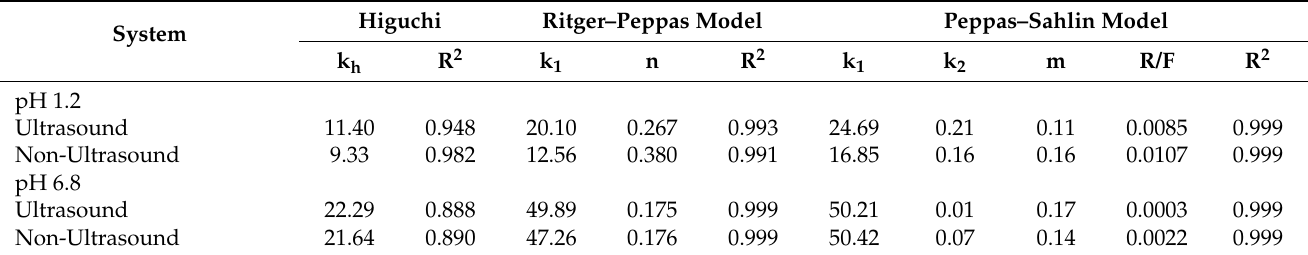
Table 4. Release kinetics of citronella oil bioactive